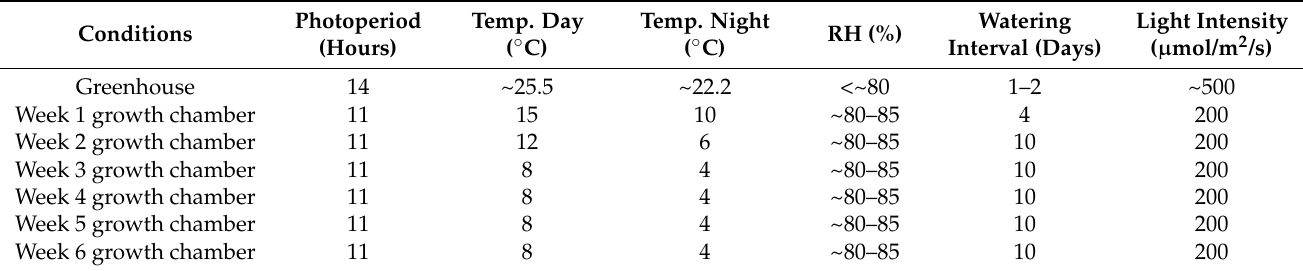
Table 2. Conditions of non-acclimated and cold-acclimated koa seedlings. There was a gradual change in the variables per condition during the cold-acclimation